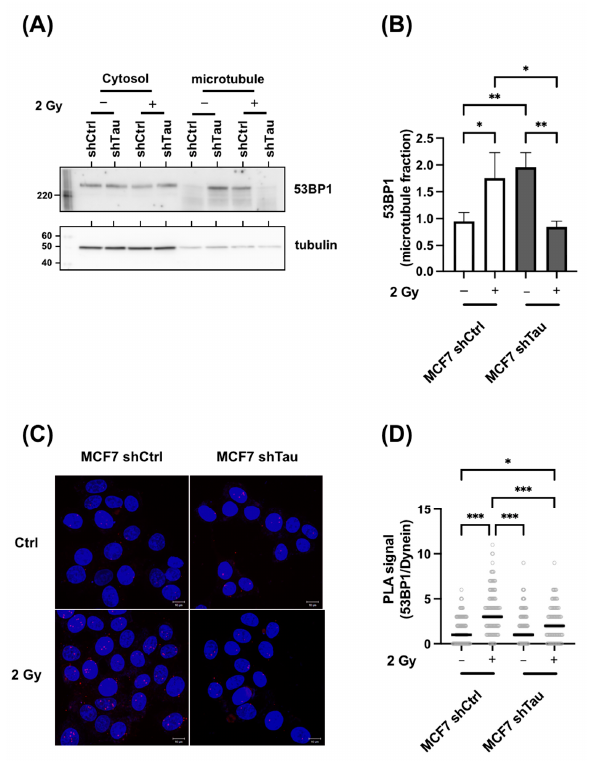
Figure 7. Tau regulates the 53BP1/microtubule interaction. ( A ) Representative 53BP1 and tubulin western blot analysis of microtubule fractions from MCF7 shCtrl and shTau cells in control or 2 Gy conditions. ( B ) The graph shows the quantification of three independent microtubule fractionation experiments followed by 53BP1 and tubulin detection by western blot. ( C ) Representative in situ Proximity Ligation Assay s howing 53BP1-Dynein interaction in MCF7shCtrl and shTau cells in con- trol and 2 Gy treated conditions. The maximum intensity projection (MIP) of the z-stack is shown.